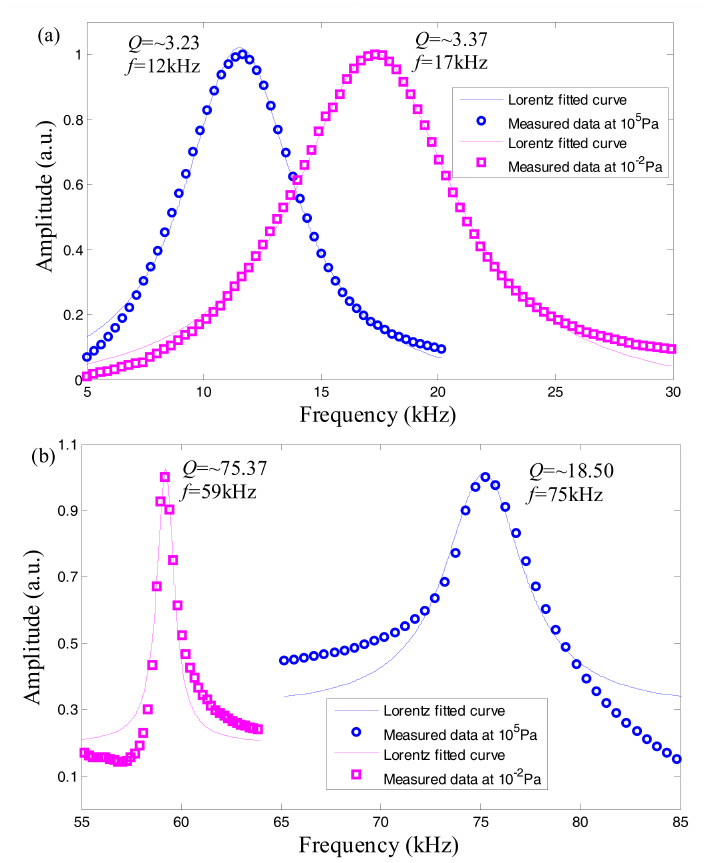
Figure 3. Resonance fundamental frequency f and Q factor at 10 5 and 10 − 2 Pa for the sensor probes with ( a ) open and ( b ) sealed cavity structures,